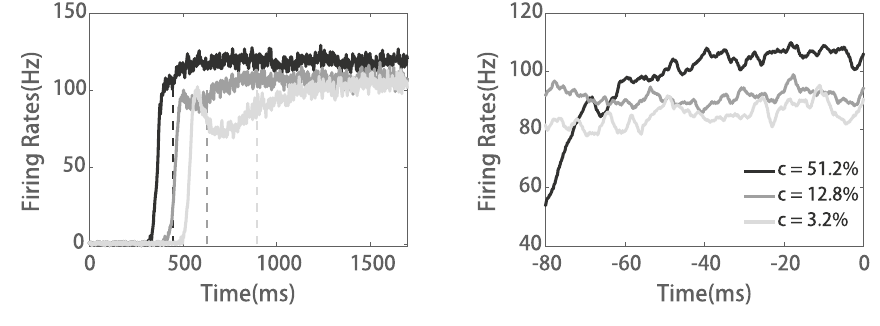
(a) Firing rates of confidence neurons aligned with the stimulus onset. The vertical dashed lines indicate the decision moment. Figure 6. Activities of confidence neurons during decision making given synaptic short-term depression.